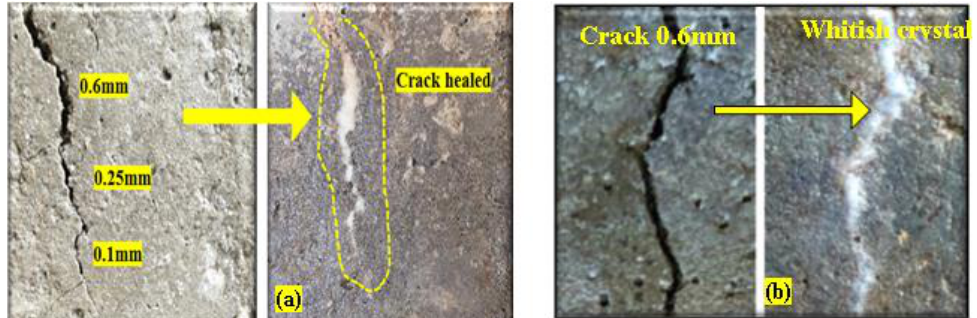
Figure 7. Healed cracks on Self-Healing Mortars with bacteria: ( a ) 10 −7 cells/mL; ( b ) 10 −9 cells/mL.